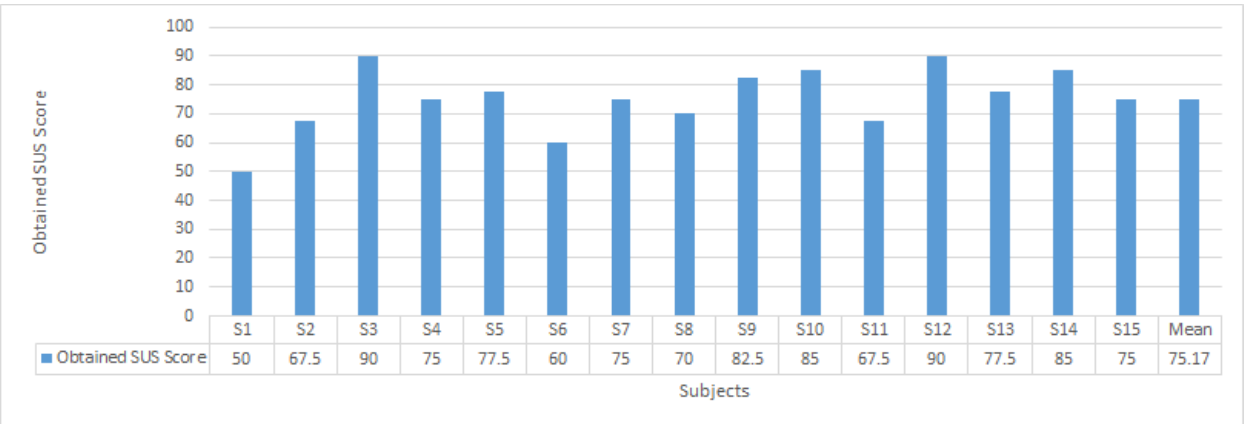
Figure 7. Usability test individual and mean obtained